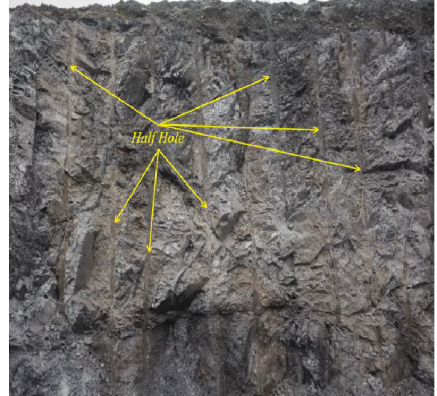
Figure 5: The slope surface smooth e ff ect.